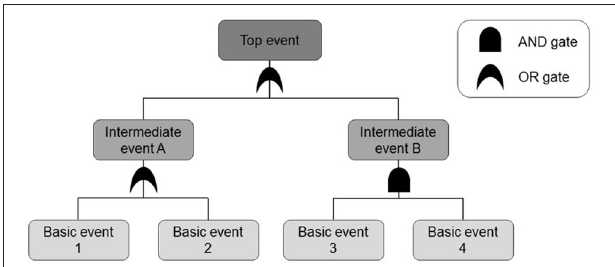
FIGURE 4 | Example of generic fault tree with a top event dependent on basic events 1–4 and intermediate events A and B.